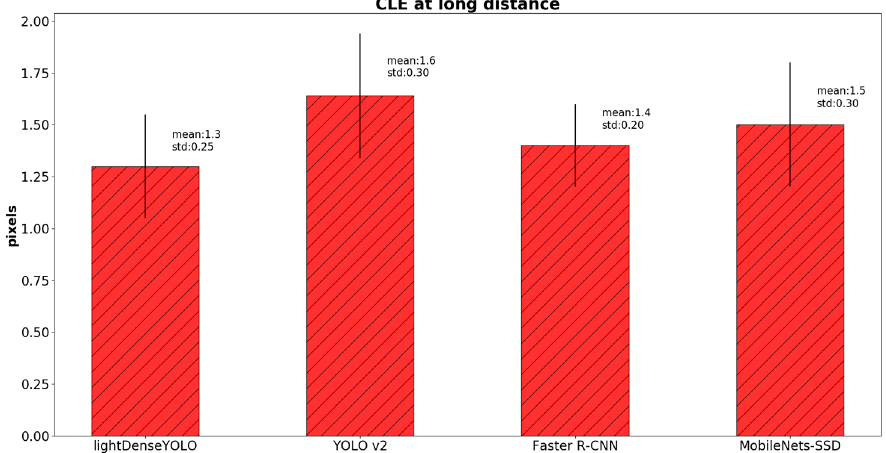
Figure 16. Comparison of center location error (CLE) of long-distance images of various methods.